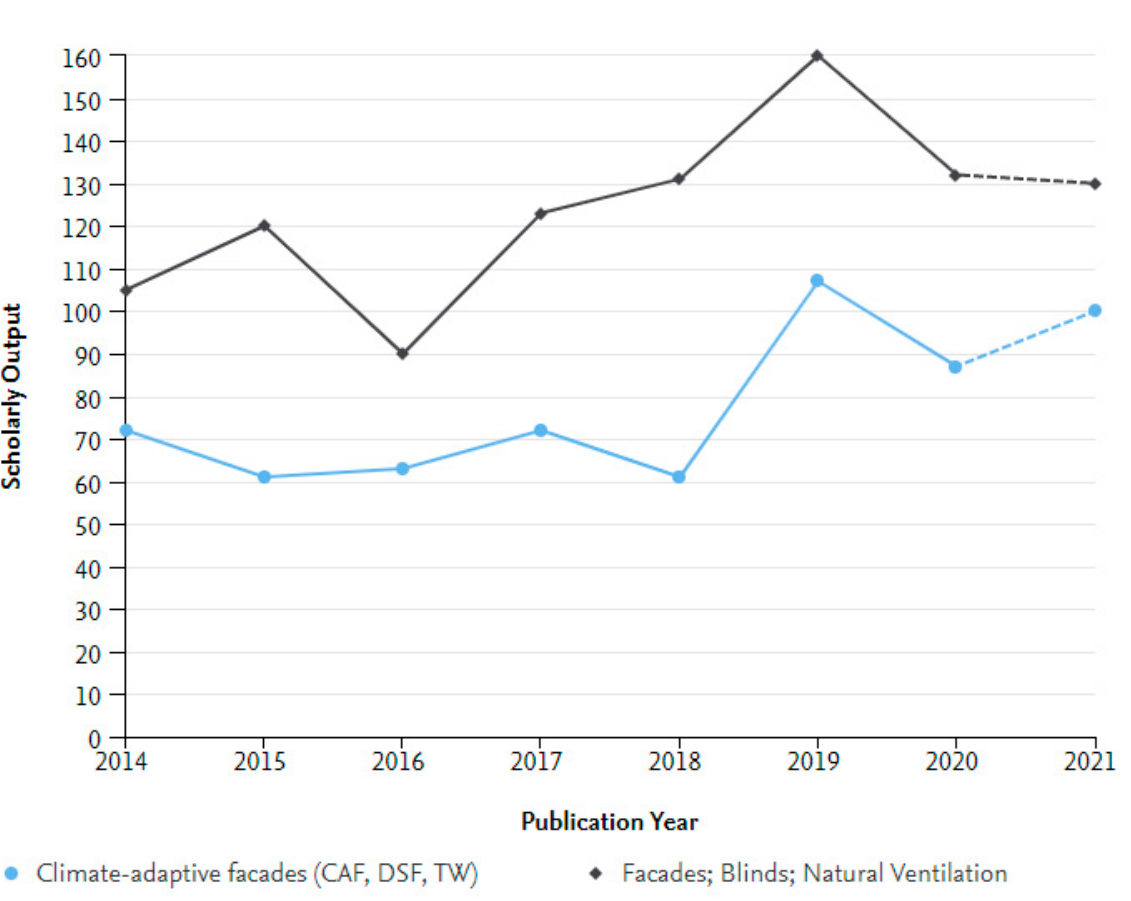
Figure 25. Benchmarking the publication year and scholarly output (accessed on 21 January 2022).